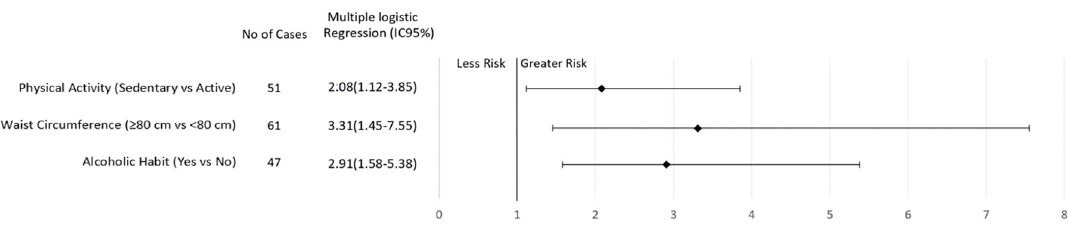
Figure 1. Association of lifestyle behavior and breast cancer risk in women according to premenopausal status.